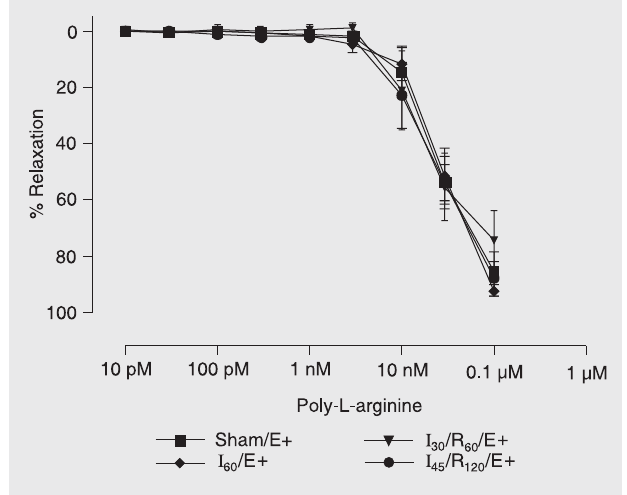
Figure 4. Concentration-response curves to poly-L-arginine by he- patic artery segments. Hepatic artery segments were exposed to sham operation (Sham), 60 min of ischemia (I 60 ), 30 min of ische- mia followed by 60 min of reperfusion (I 30 /R 60 ), and 45 min of ischemia followed by 120 min of reperfusion (I 45 /R 120 ) with endo- thelium (E+). Data are reported as means ± SEM, N = 6 per group. Arterial segments were first contracted with prostaglandin F 2 α and exposed to increasing drug concentrations. No significant differ- ence was found among groups